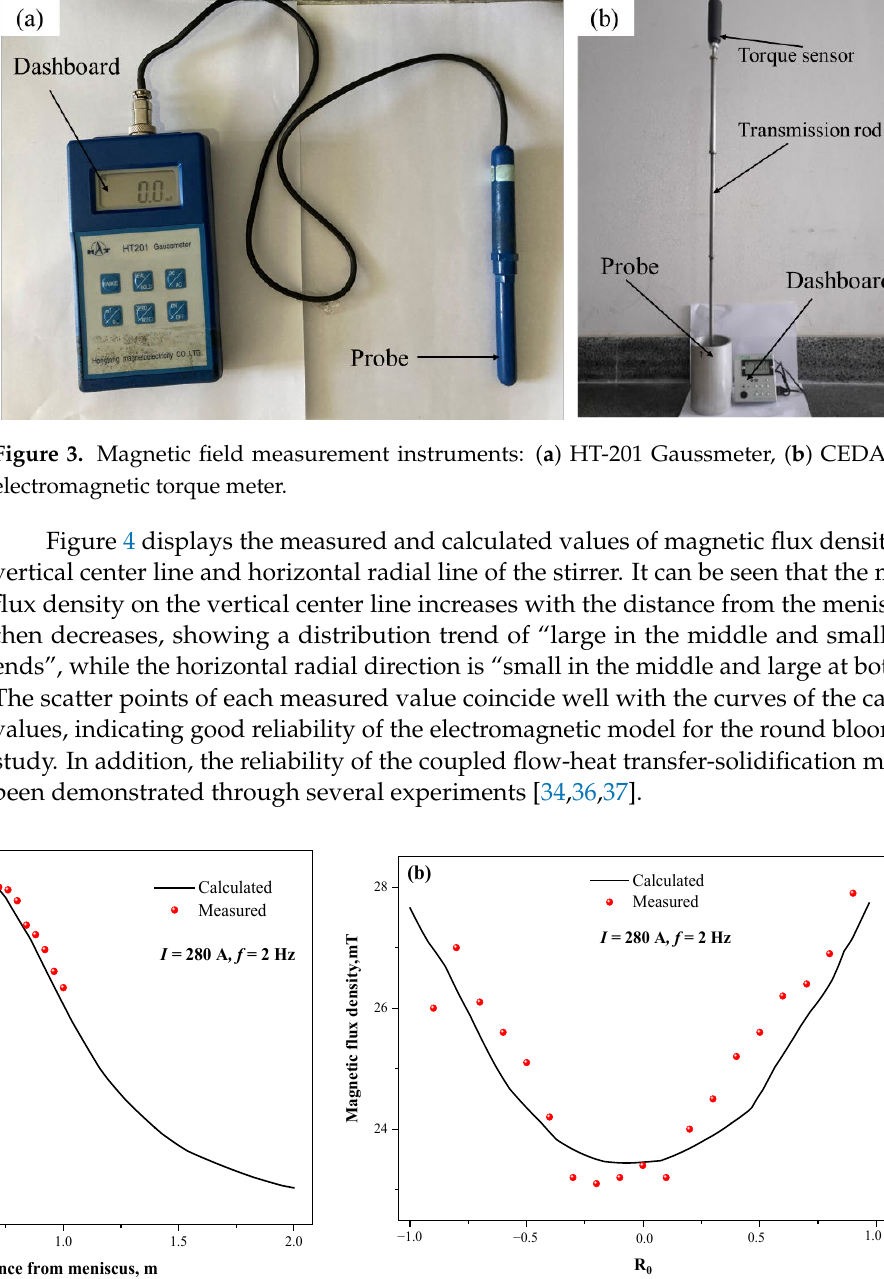
Figure 4. Comparison of calculated and measured values of magnetic flux density: ( a ) vertical center line; ( b ) horizontal radial line.